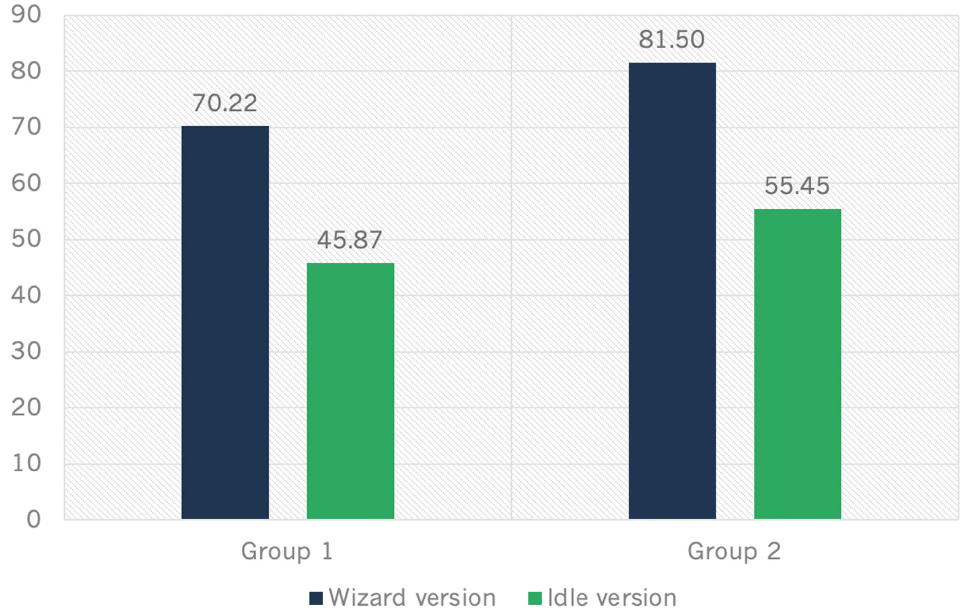
Figure 4. Number of words produced during speaking task by subjects in each of the two groups. Wizard condition indicates an experimental setting where the virtual agent nonverbal feedback was triggered by the wizard. Idle condition indicates an experimental setting where the virtual agent is in an idle state and does not provide any nonverbal feedbacks.